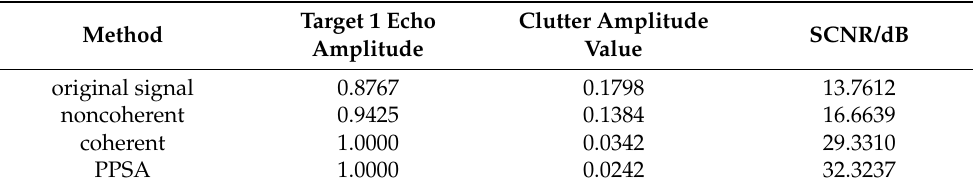
Table 16. SCNR comparison of target